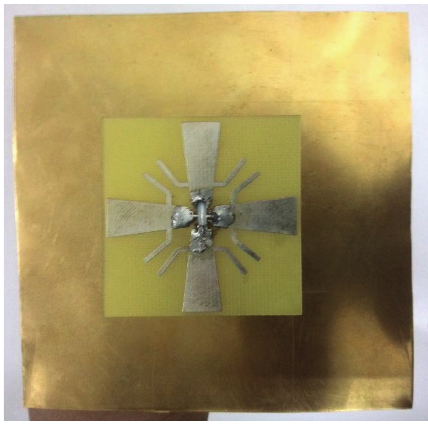
Figure 5: Photograph of the proposed antenna.